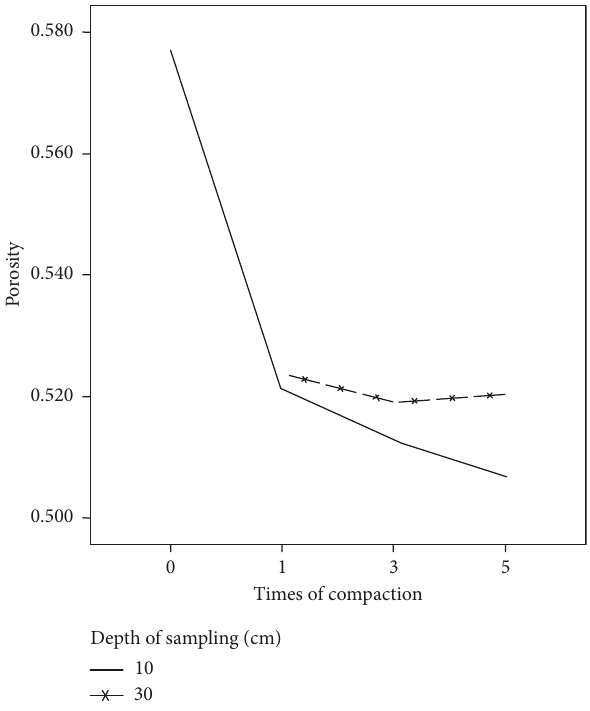
Figure 8: Change of the porosity of different depths of sampling to times of